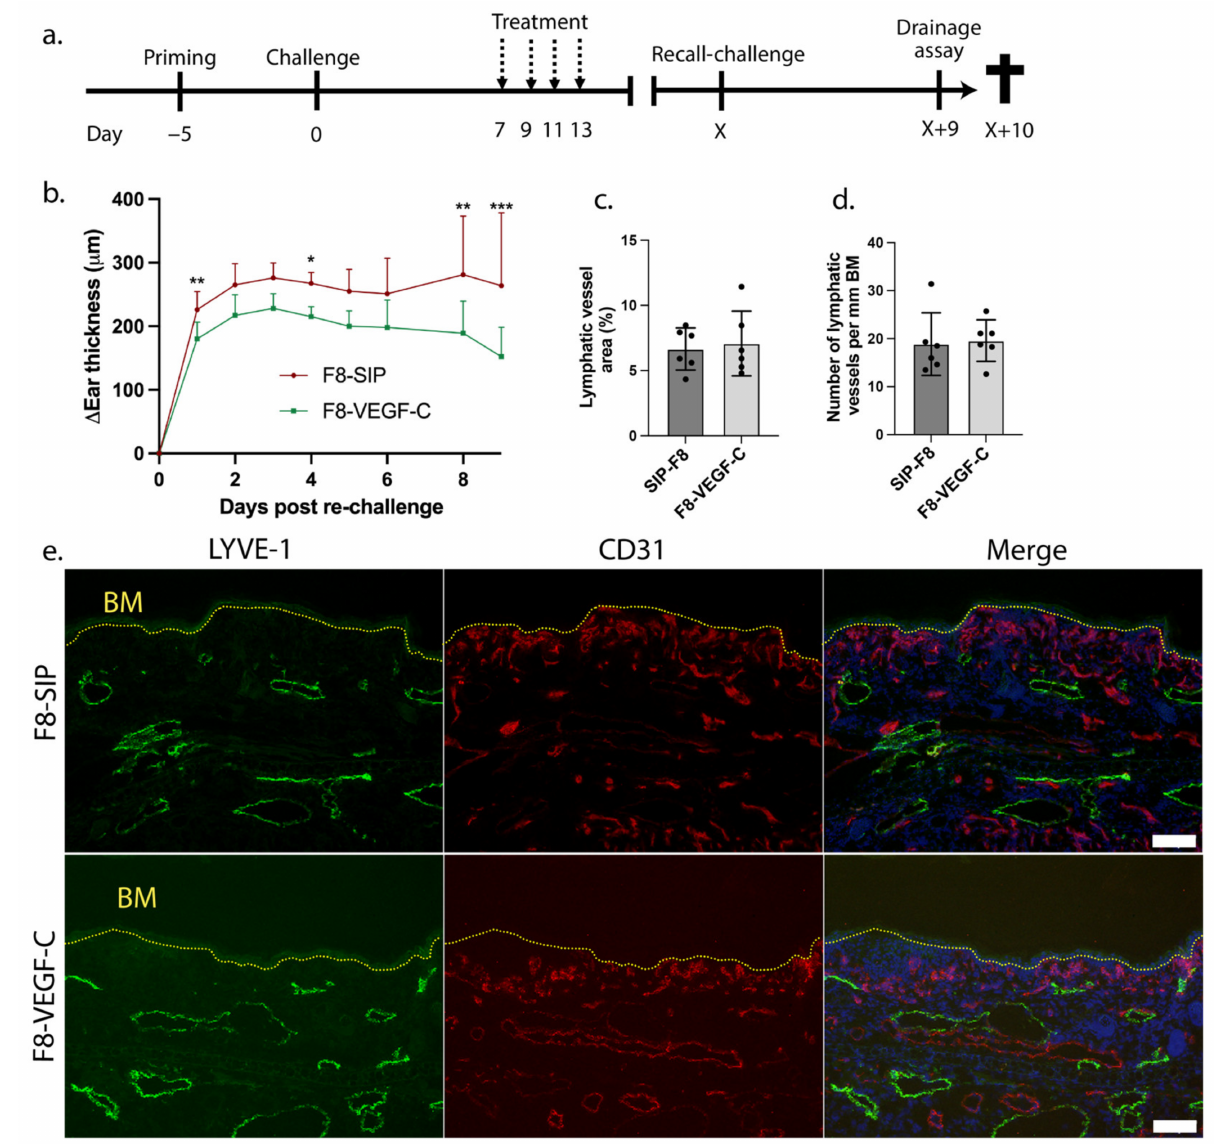
Figure 3. ( a ) Schematic representation of the long-term inflammation experimental setup with the treatment regimen on days 7, 9, 11, and 13 (dashed arrows). X indicates the day when the ear thickness of both treatment groups had returned to baseline, and therefore the day when inflammation was resolved. ( b ) Changes in ear thickness over 10 days after re-challenge in F8-SIP and F8-VEGF-C- treated K14-VEGF-A transgenic mice relative to ear thickness before re-challenge ( n = 4–5 mice per group, 2-way ANOVA with Bonferroni post-test; one representative of two independent experiments shown). ( c ) Quantitative analysis of lymphatic vessel area as % of the region of interest at day 10 after re-challenge (expressed as a mean %, n = 6 mice per group, two-tailed Student’s t -test, one representative of two independent experiments shown). ( d ) Analysis of number of lymphatic vessels in previously F8-SIP and F8-VEGF-C-treated K14-VEGF-A transgenic mice on day 10 after re-challenge (expressed as mean number per mm basement membrane length, n = 6 mice per group, two-tailed Student’s t -test, one representative of two independent experiments shown). ( e ) Representative immunofluorescence images of ears from F8-SIP and F8-VEGF-C-treated K14- VEGF-A transgenic mice stained for Lyve-1 (green), CD31 (red), and Hoechst 33342 (blue) on day 10 after re-challenge. Dotted yellow line: basement membrane (BM). Size bars: 100 µ m. All data are presented as mean ± SD. * p < 0.05, ** p < 0.01, *** p <